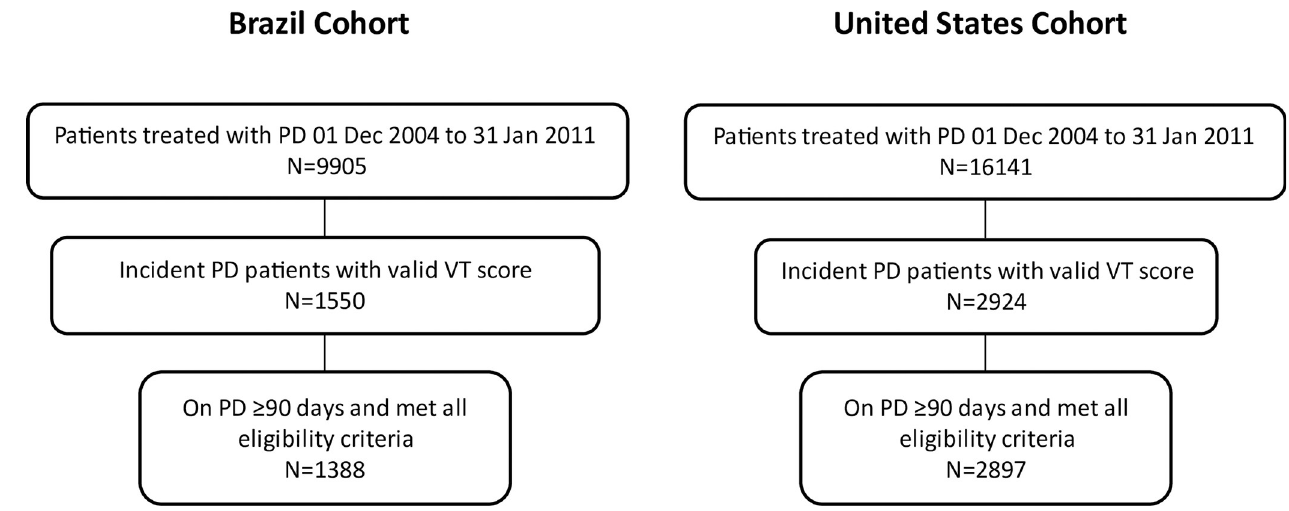
Fig 1. Flow chart of patients included in the Brazil and United States cohorts.